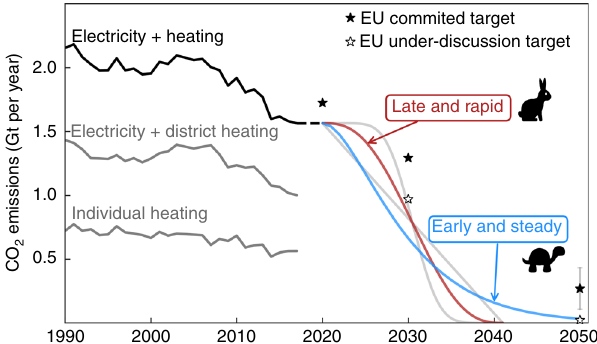
Fig. 1 Historical CO 2 emissions from the European power system and heating supply in the residential and services sectors. Data from EEA 8 . The various future transition paths shown in the fi gure have the same cumulative CO 2 emissions, which correspond to the remaining 21 GtCO 2 budget to avoid human-induced warming above 1.75 °C with a probability of >66%, assuming current sectoral distribution for Europe, and equity sharing principle among regions. Black stars indicate committed EU reduction targets, while white stars mark targets under discussion in 2020. See also Supplementary Fig.